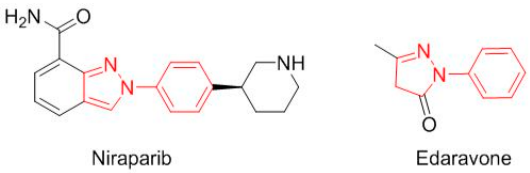
Figure 12. Structure of drugs derived of the N -phenyl-pyrazole (in red) structure.